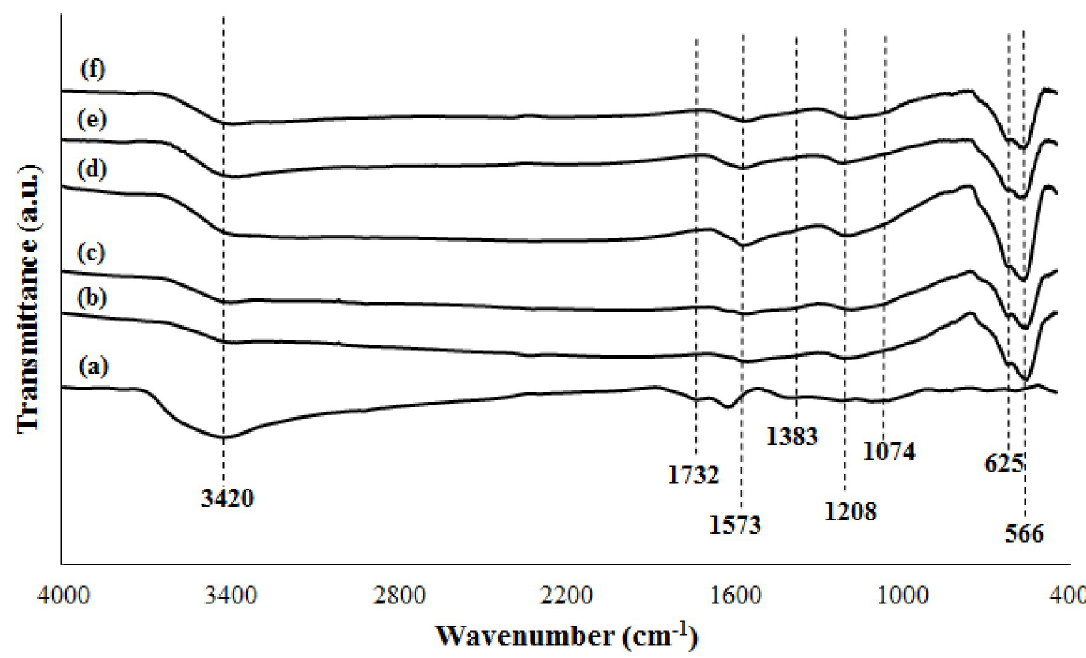
Fig 4. FTIR spectra of (a) GO, (b) M-rGO3, (c) M-rGO6, (d) M-rGO12, (e) M-rGO18 and (f) M-rGO24.